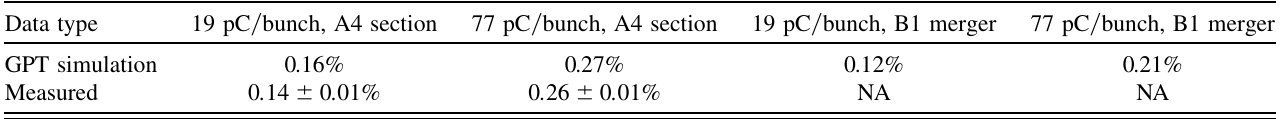
TABLE IV. Simulated and measured rms energy spread as a function of bunch